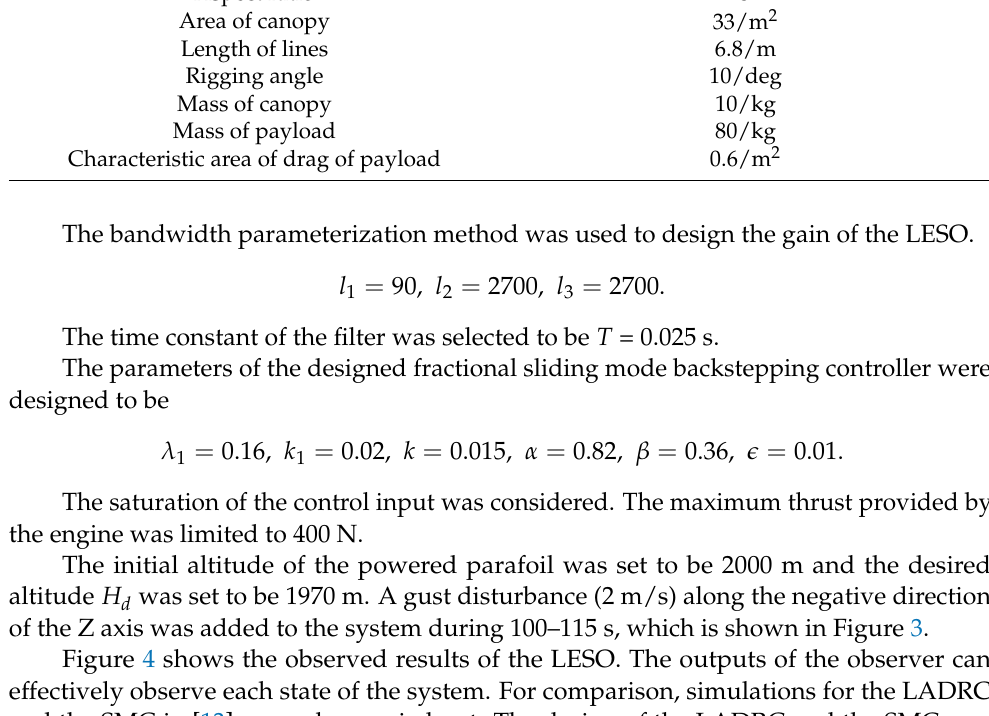
Table 1. Structure parameters of the powered parafoil. Paremeter Value/Unit Span 10.5/m Chord 3.1/m Aspect ratio 3 Area of canopy 33/m 2 Length of lines 6.8/m Rigging angle 10/deg Mass of canopy 10/kg Mass of payload 80/kg Characteristic area of drag of payload 0.6/m 2